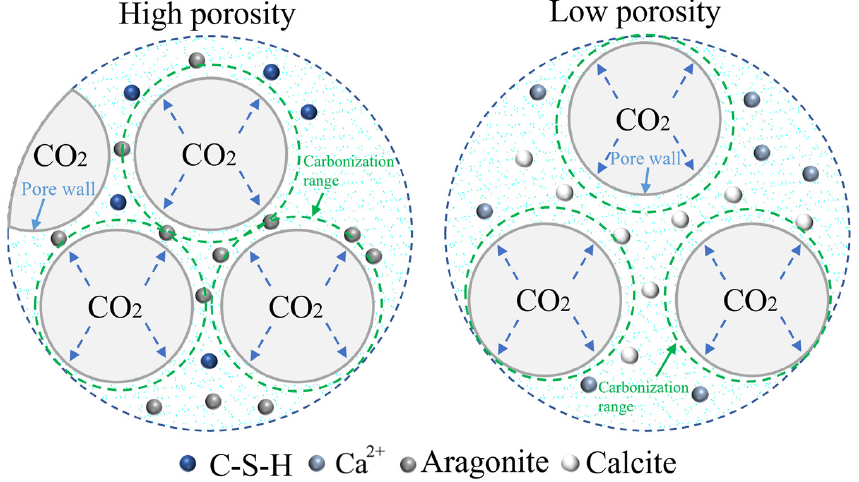
Figure 4. Effect of CO 2 on the hole wall structure under different porosities.